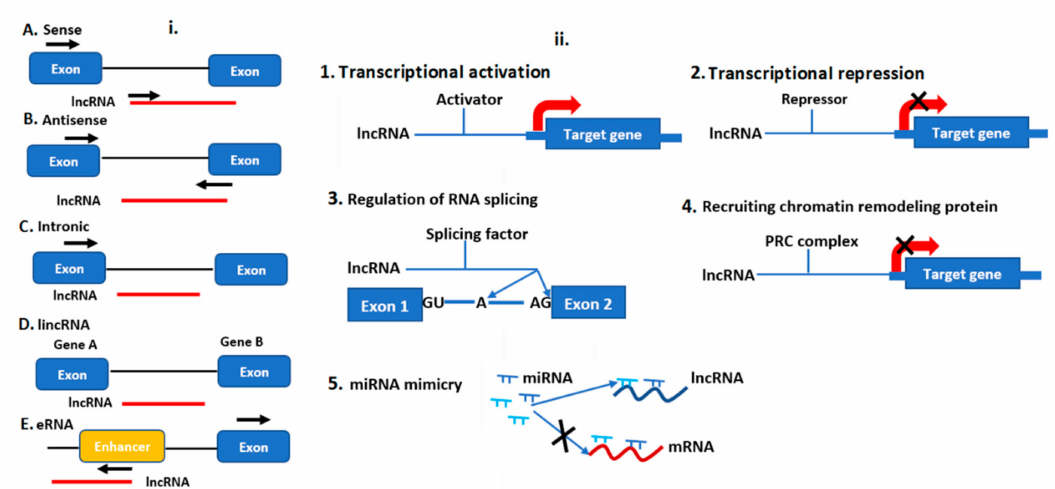
Figure 4. The biogenesis of long-non-coding RNAs (lncRNAs) and their gene regulation mechanisms in plants. ( i ) The transcripts of lncRNA (red box) are classified on the basis of their genomic location and in relation to the nearest gene (blue box): ( A ) sense lncRNAs are transcribed on the same strand as an exon; ( B ) antisense lncRNAs are transcribed on the opposite strand of an exon; ( C ) intronic lncRNAs are transcribed on the intron; ( D ) intergenic lncRNAs are located between two distinct genes; ( E ) enhancer lncRNAs emerge from an enhancer region of protein-coding genes. ( ii ) The gene regulation pathways induced in plants by lncRNAs. LncRNAs regulate gene expression either by: ( 1 ) interacting with transcriptional activator leading to gene activation; ( 2 ) interacting with transcriptional repressor thereby suppressing transcription; ( 3 ) controlling RNA splicing by interacting with splicing factor or binding premRNA splicing junction; ( 4 ) recruiting chromatin remodeling complex such as PRC to regulate gene expression in the promoter region; ( 5 ) LncRNA mimics miRNAs by occupying their target sites on the